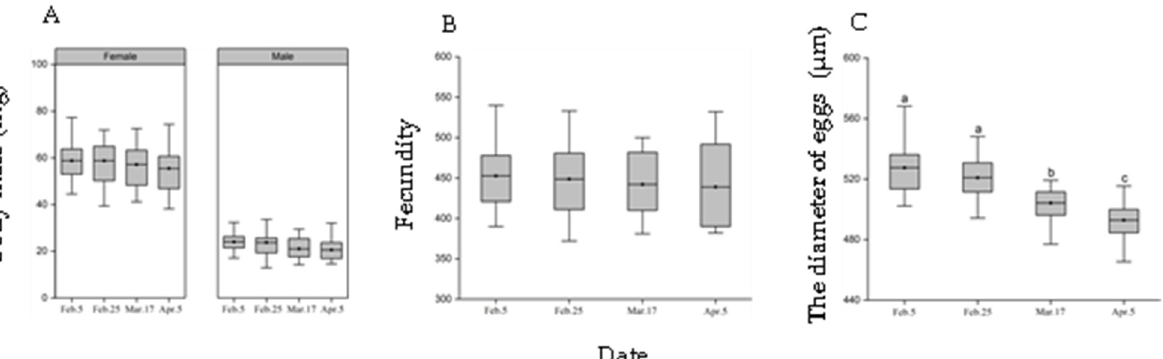
Figure 5. Effect of heating time inside the transfer chamber on the fitness of adults. ( A ): adult mass, ( B ): fecundity, ( C ): egg diameter. Different letters indicate significant differences from one another at p < 0.05 (female body mass: n = 28–39; male body mass: n = 25–34; fecundity: n = 10; egg diameter: 27–35). The top and bottom of each box represents the upper and lower quartile, respectively; the horizontal line represents the mean; the vertical lines extend to the minimum and maximum values within 1.5 times the inter-quartile range.